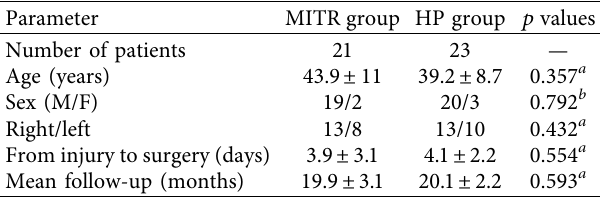
Table 1: Main demographic characteristics.